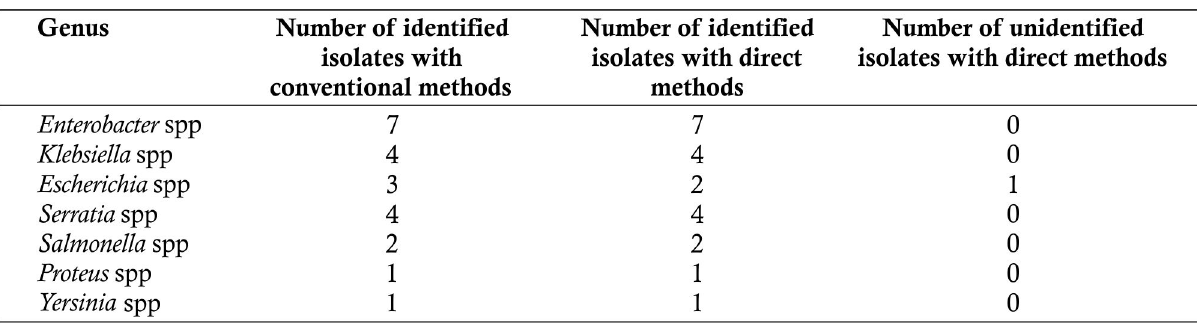
Enterobacteriaceae Identification